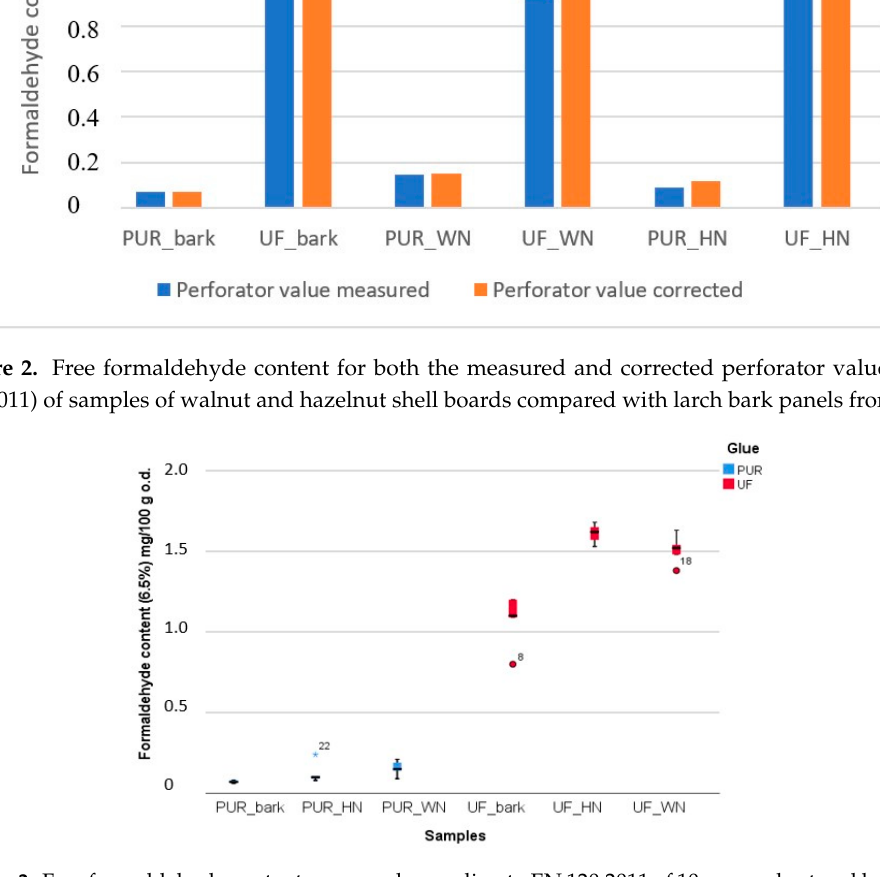
Figure 3. Free formaldehyde content measured according to EN 120:2011 of 10 mm walnut and hazelnut panels bonded with UF and MUF and compared with the values of larch bark boards glued with the same adhesives from [53].